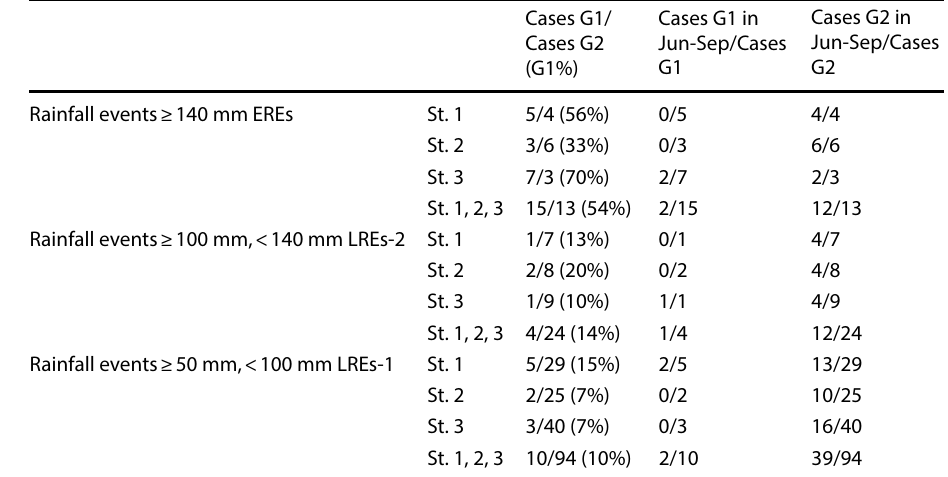
Table 3 Rainfall event numbers classified to G1 (Cases G1; Na + , Cl − , and Chla values were ≤ 25th percentiles) and to G2 (Cases G2; others) (proportion of G1 in all cases), and Cases G1 and G2 occurred for